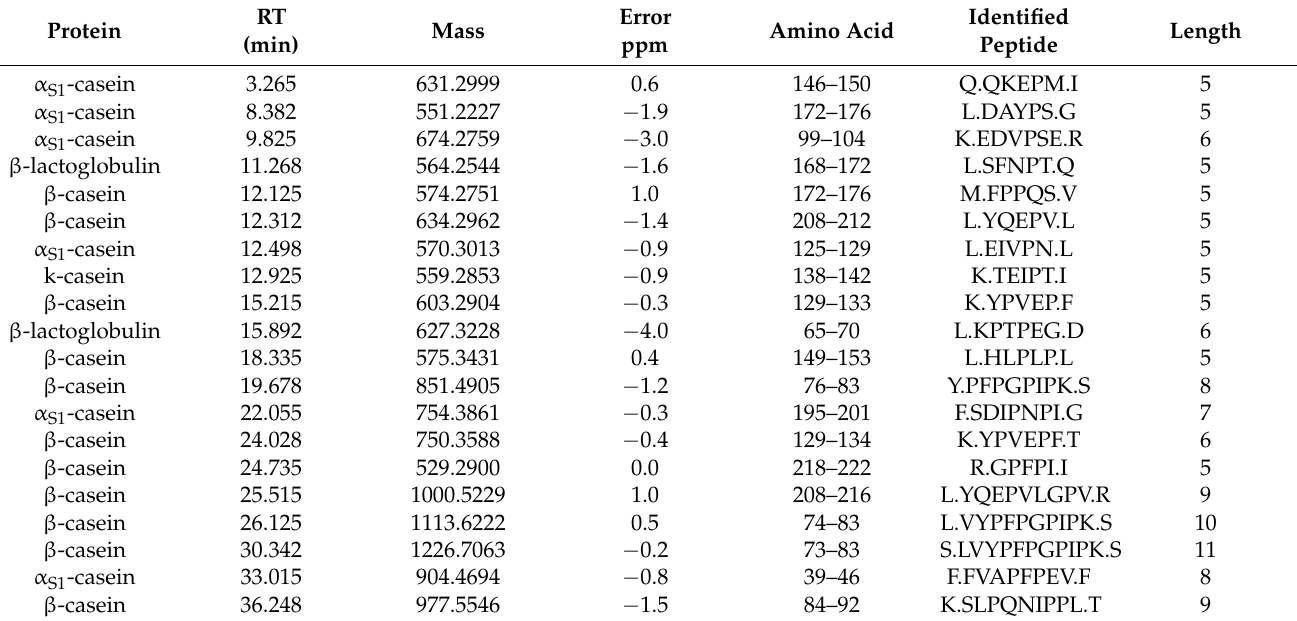
Table 1. Main peptides released during GI digestion of ice cream